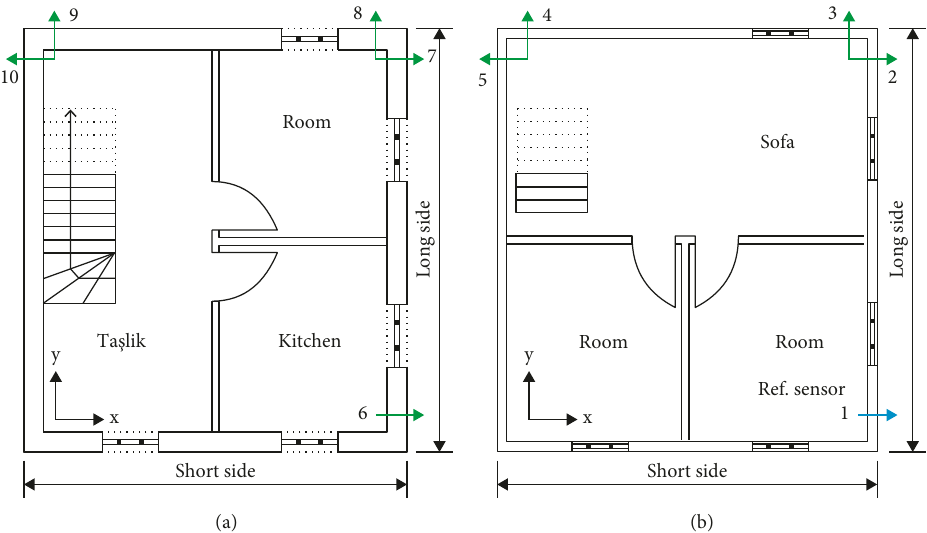
Figure 9: The sensor placements of the houses on plan views: (a) ground floor; (b) upper